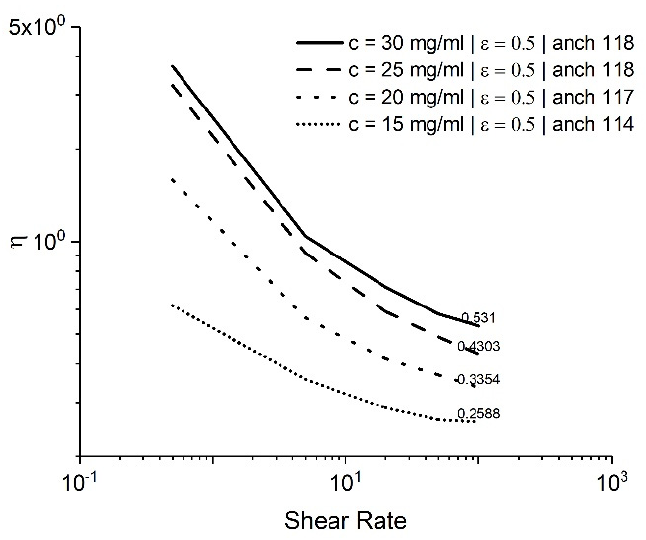
Figure 10. Dimensionless viscosity vs. shear rate obtained at different concentrations for ϵ = 0.5 at different anchoring angles using the EL theory.